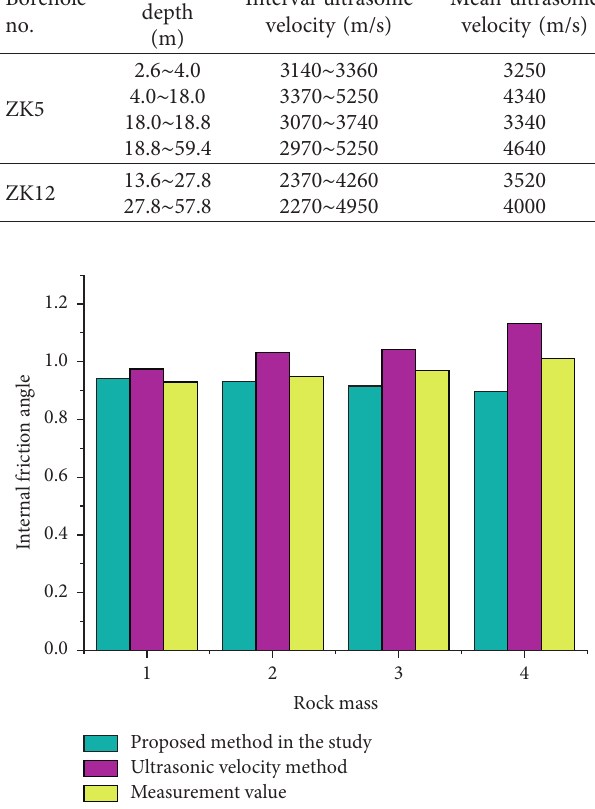
Table 3: The ultrasonic velocity values of the rock mass in the Mamaya I hydropower station. Borehole no.